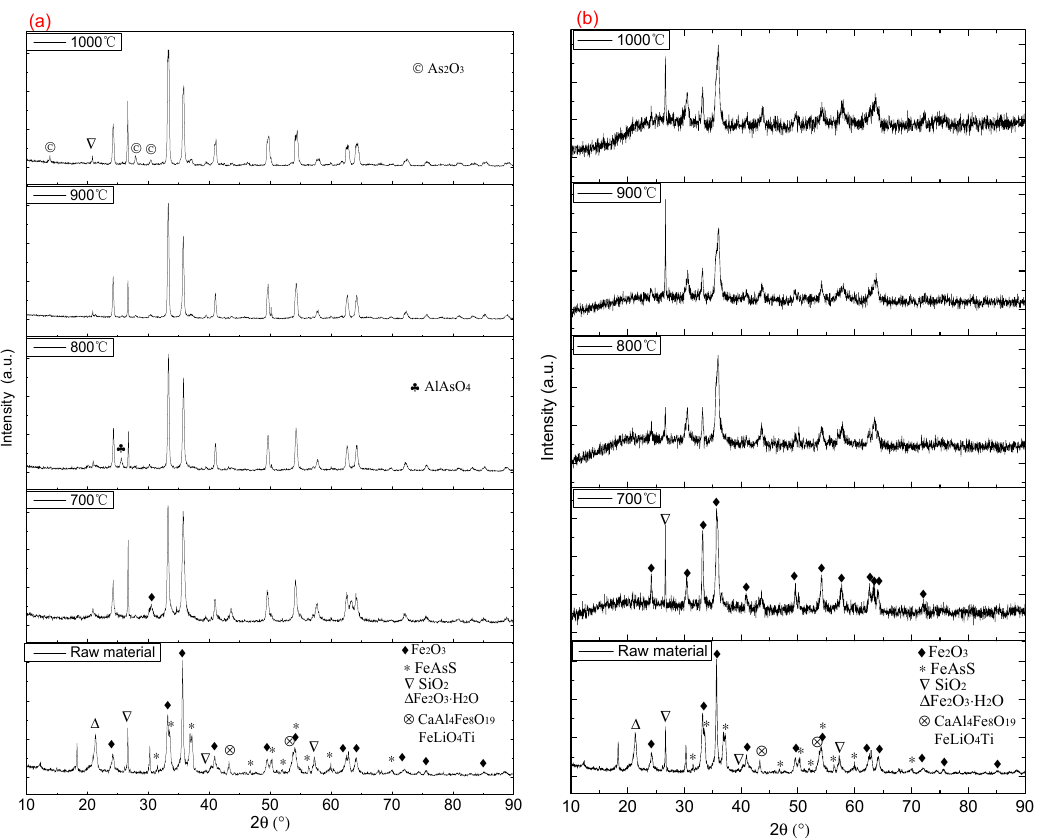
Figure 5. XRD spectra of the roasted ore and dust in: ( a ) Air and ( b ) nitrogen atmosphere.